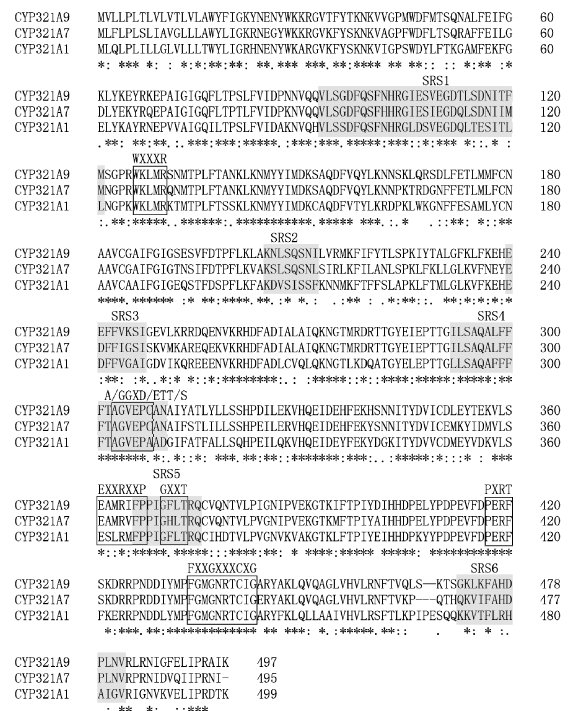
Figure 2. Alignment of the amino acid sequences deduced from CYP321A7 ( Spodoptera litura ),